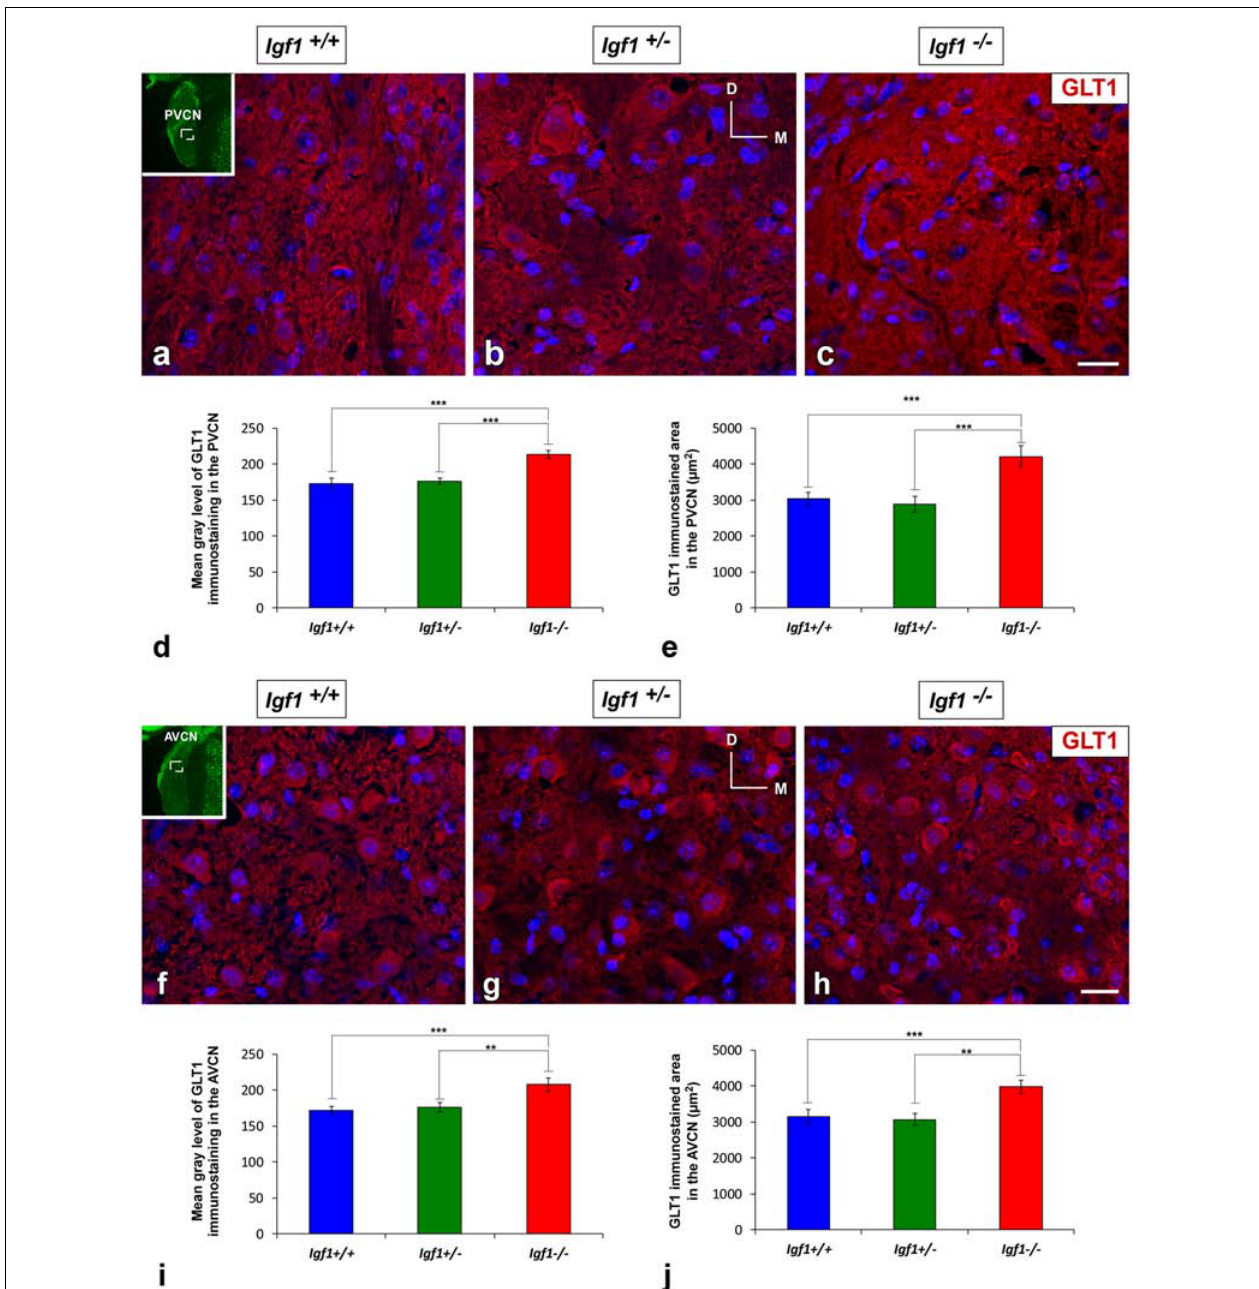
FIGURE 8 | Upregulation of GLT1 in the ventral cochlear nuclei of Igf1 − / − mice. Z-stack confocal microscopy images show enhanced GLT1 immunostaining (red) in the IGF-1 deficient ventral cochlear nucleus (C,H) relative to the Igf1 + / + (A,F) and Igf1 + / − mice (B,G) . Quantification of the immunostaining confirmed this upregulation in both the PVCN (D,E) and AVCN (I,J) . The inset in ( A,F ; pseudo-colored green for higher contrast) indicates the approximate location of the fields shown in (A–C,F–H) ; for the PVCN and AVCN, respectively. The error bars indicate the standard deviations of the mean. Statistically significant differences among the animal groups were evaluated by one-factor ANOVA ( ∗∗ p < 0.01, ∗∗∗ p < 0.001). Cell nuclei are stained with DAPI (blue). Abbreviations: AVCN, anteroventral cochlear nucleus; GLT1, glutamate transporter 1; PVCN, posteroventral cochlear nucleus. Scale bar: 20 µ m in ( C,H ; it also applies to A,B,F,G